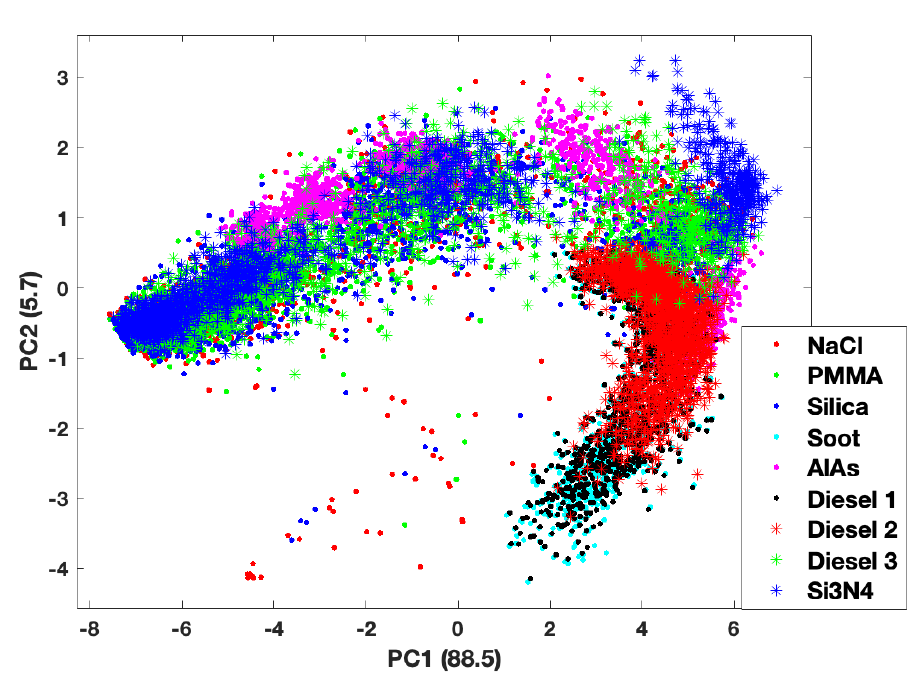
Figure 5. Scatter plot of the scores values for first 2 principal components of the forward scattering dataset by aggregate